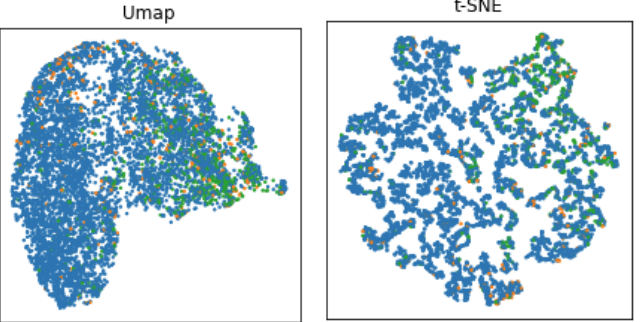
Figure 2. Visualization of HAM10000 dataset distribution on three anatomic sites with UMAP and t-SNE data transformation. The blue dots represent trunk and extremities, orange dots represent acral, and green dots represent face and head skin